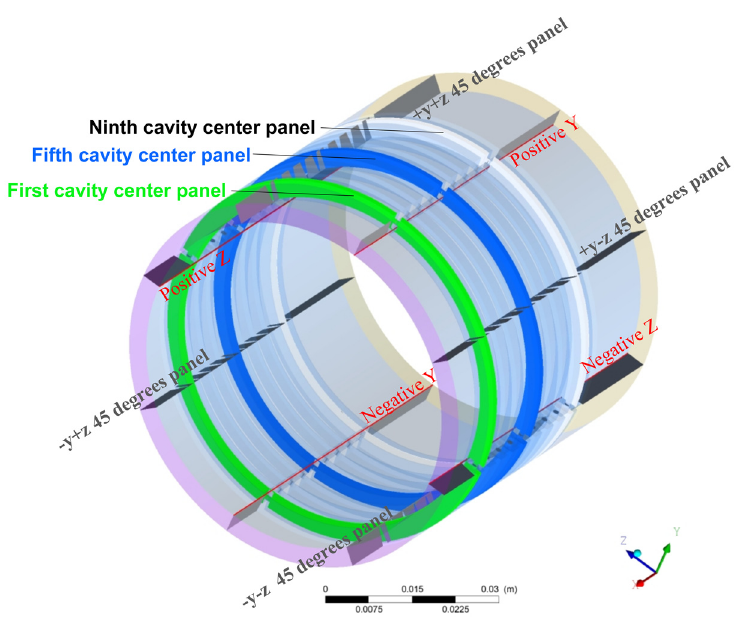
Figure 3. Analysis panels and lines setting.